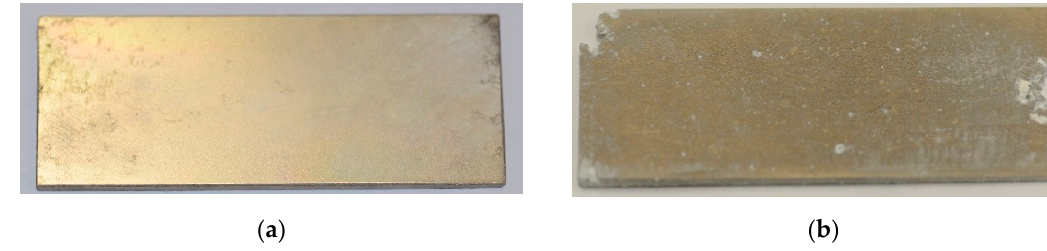
Figure 3. Macro morphology of as-cast WE43 ( a ) before the 1st day and ( b ) after the 7th day.